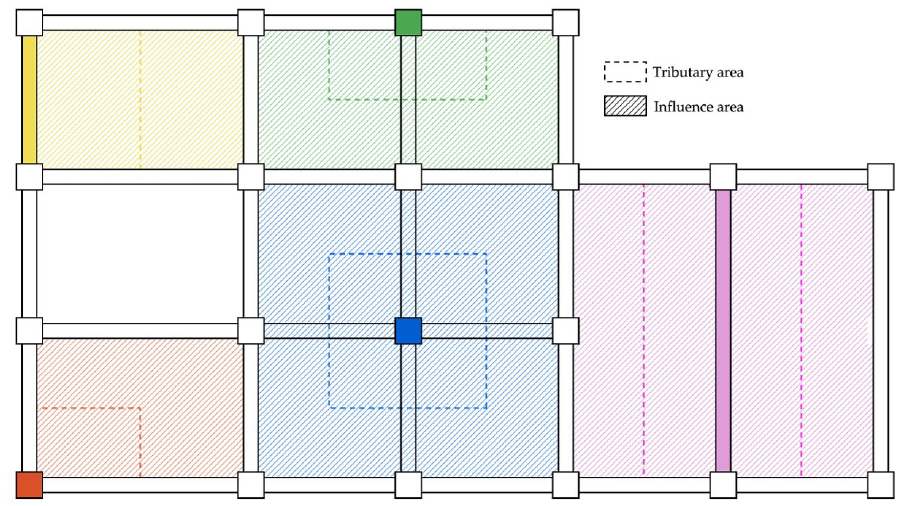
Figure 2. Tributary and influence areas for typical structural